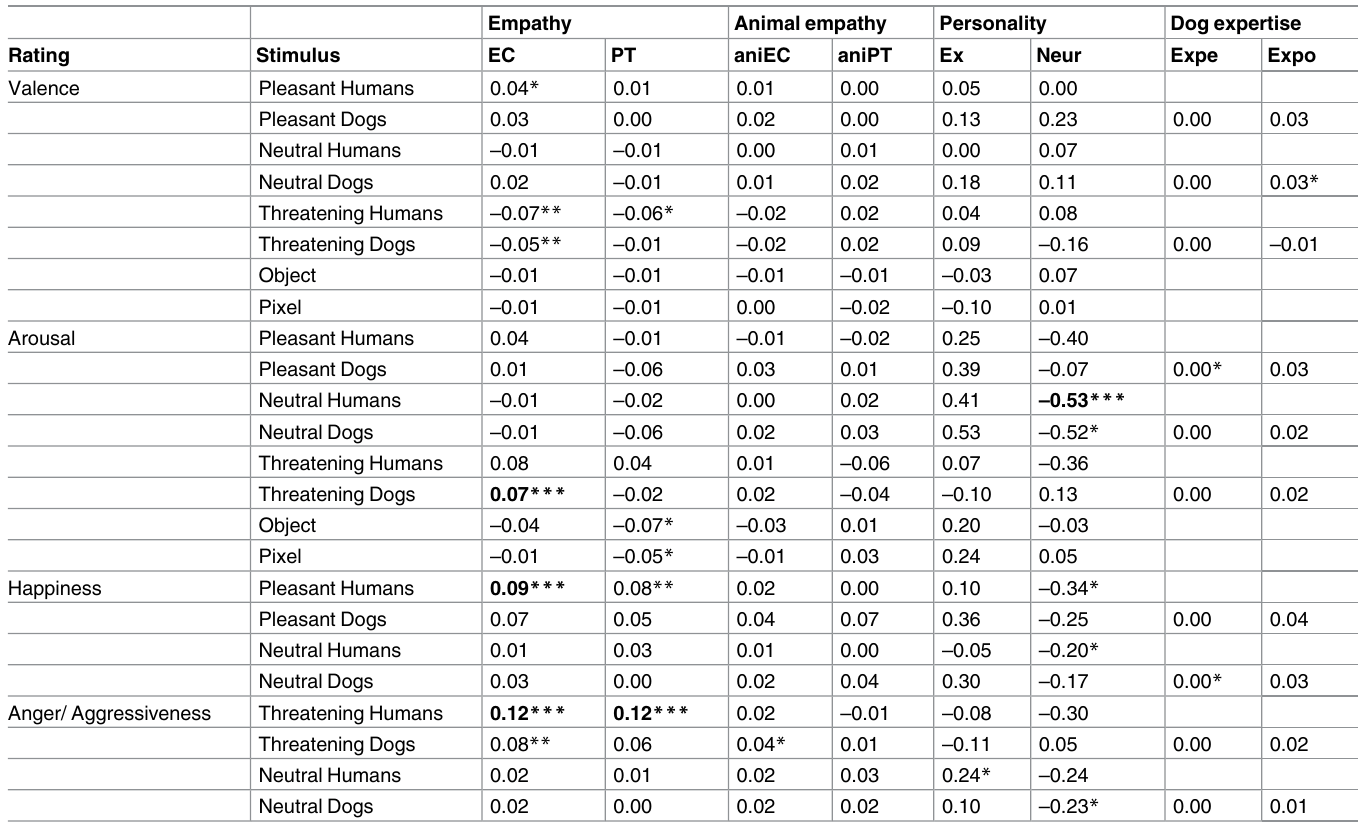
Table 3. Connections of psychological factors to the stimulus ratings. Ratings of arousal, valence,happinessand anger/aggressiveness were pre- dicted with Extraversion (Ex), Neuroticism(Neur), Emotional Concern(EC), Perspective-taking (PT), animal-directed Emotional Concern(aniEC) and animal- directed Perspective-taking(aniPT) factors. Connectionsof dog stimulus ratings with dog experience were obtained with dog expertise(Expe) and dog expo- sure (Expo) predictors. Significantregression coefficients(beta values) are marked with asterisks ( * p < 0.05, ** p < 0.01, *** p < 0.001) and the results with p- values above the FDR thresholdare written in bold